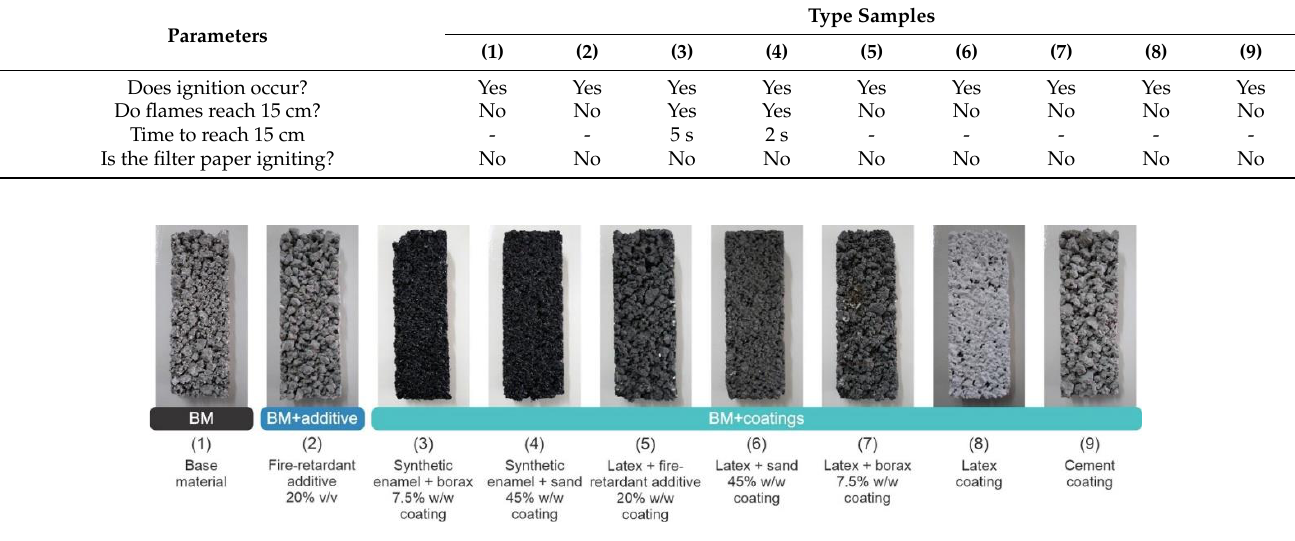
Figure 24. Types of samples used in the single flame source test. Reprinted with permission from ref. [66]. ref.